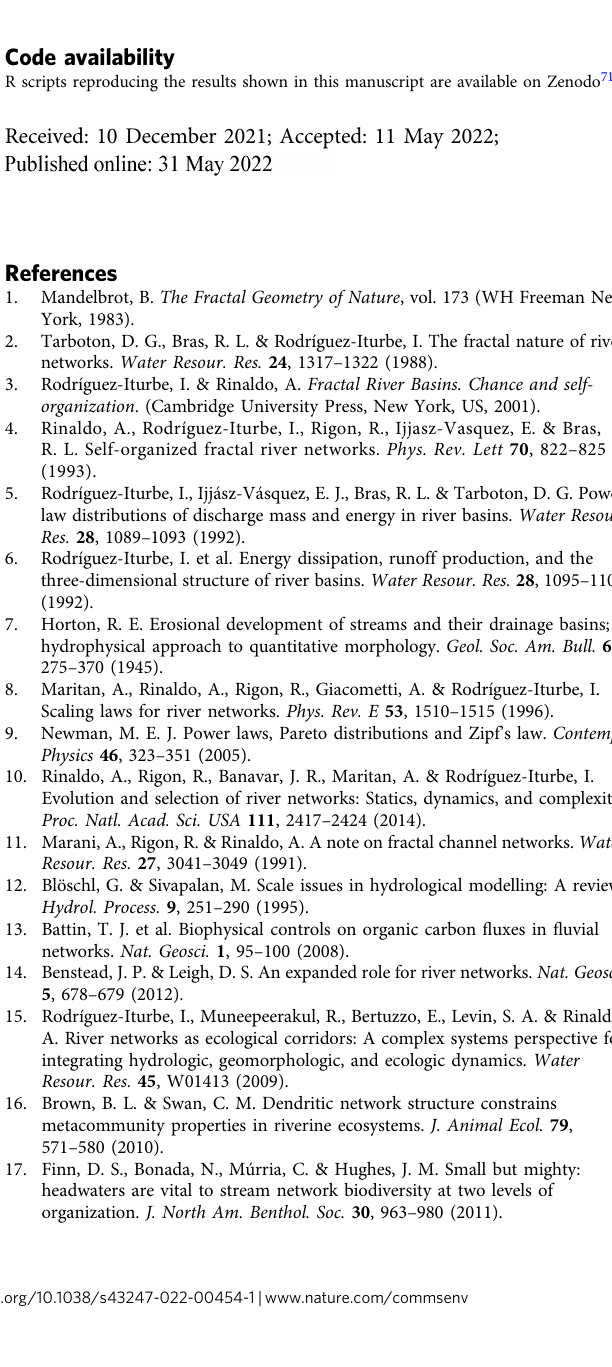
q ffiffiffiffiffiffiffiffiffiffiffiffiffiffiffiffi ∑ N 2 , as a measure of the role of patch size distribution on i i ¼ 1 H metapopulation